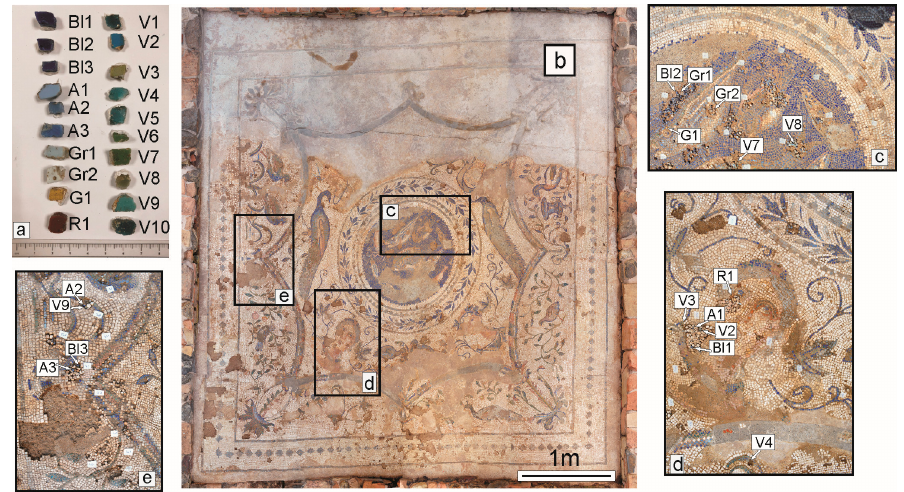
Figure 2. ( a ) Glass tesserae studied, grouped by colour. ( b ) Four Seasons mosaic. ( c – e ) Details of sampling.